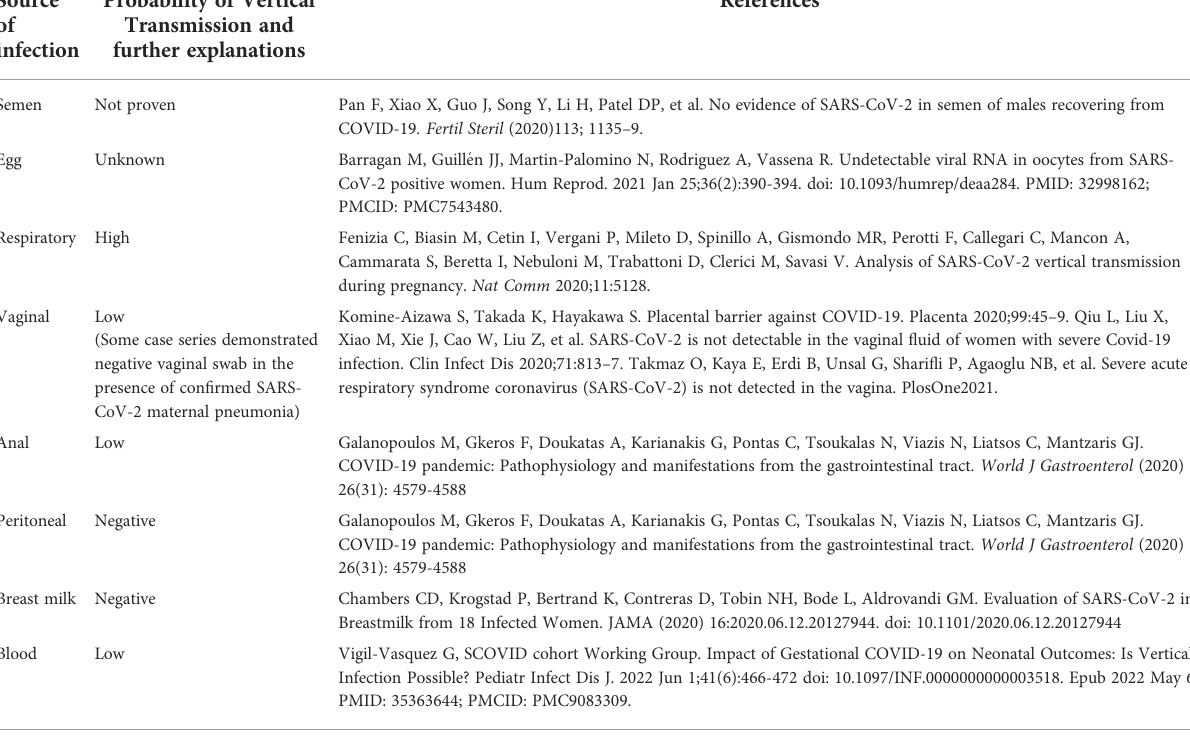
TABLE 1 Possible sources of infection and relative probability of vertical